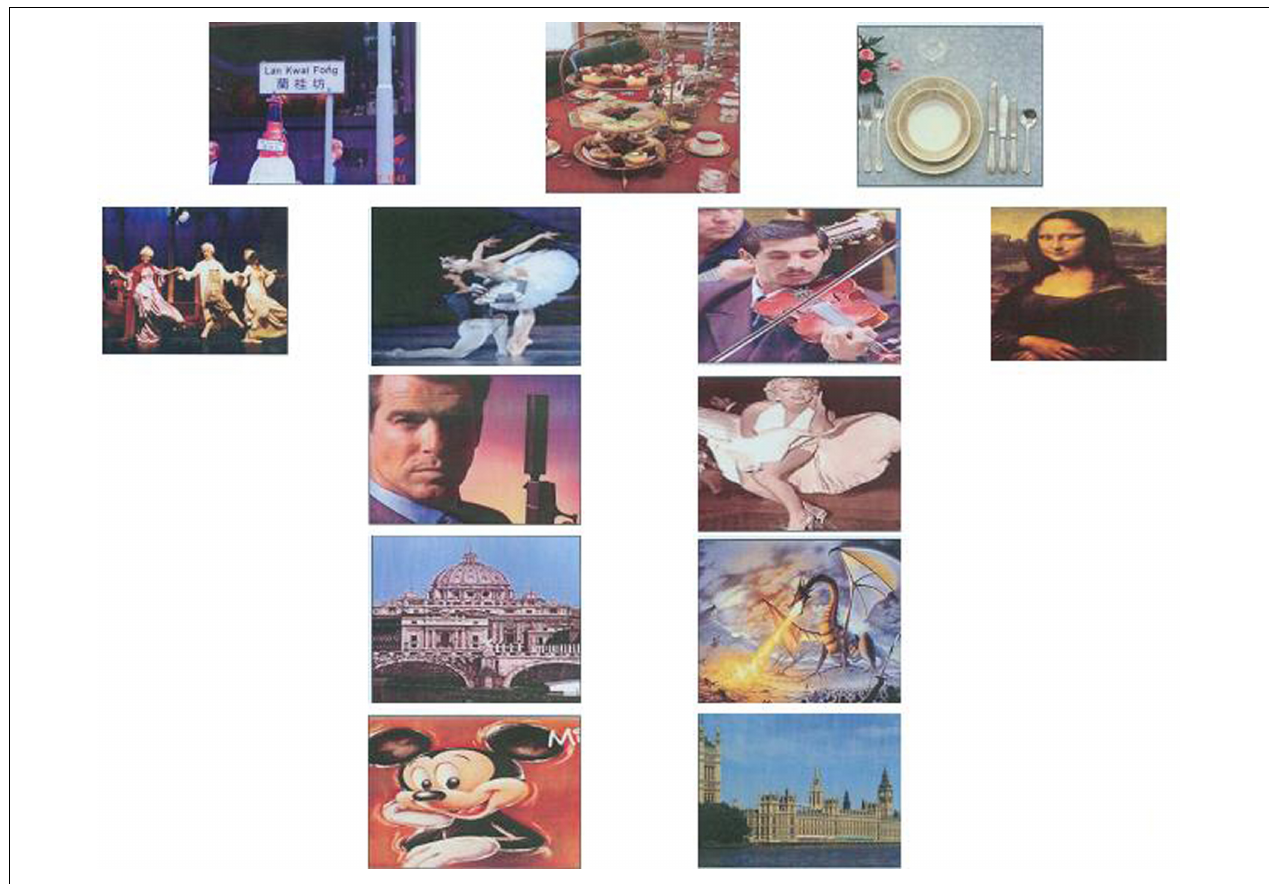
FIGURE 2 | Western